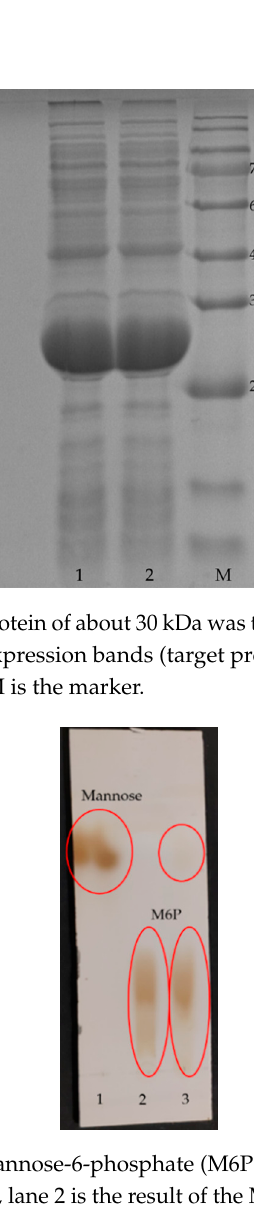
Figure 2. Qualitative detection of mannose-6-phosphate (M6P) by thin layer chromatography. Lane 1 is the result of the mannose standard, lane 2 is the result of the M6P standard, and lane 3 is the result of the reaction